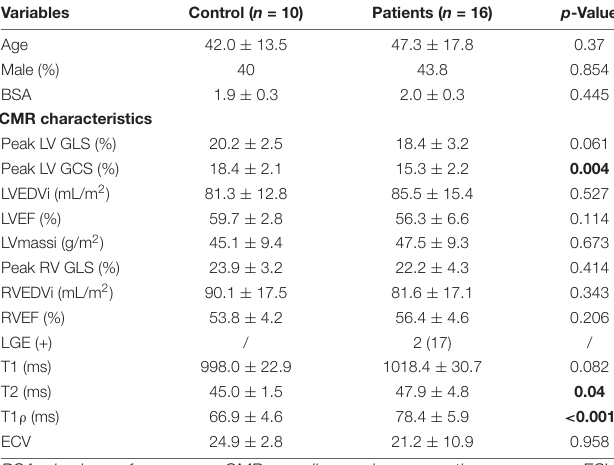
TABLE 1 | Subject baseline